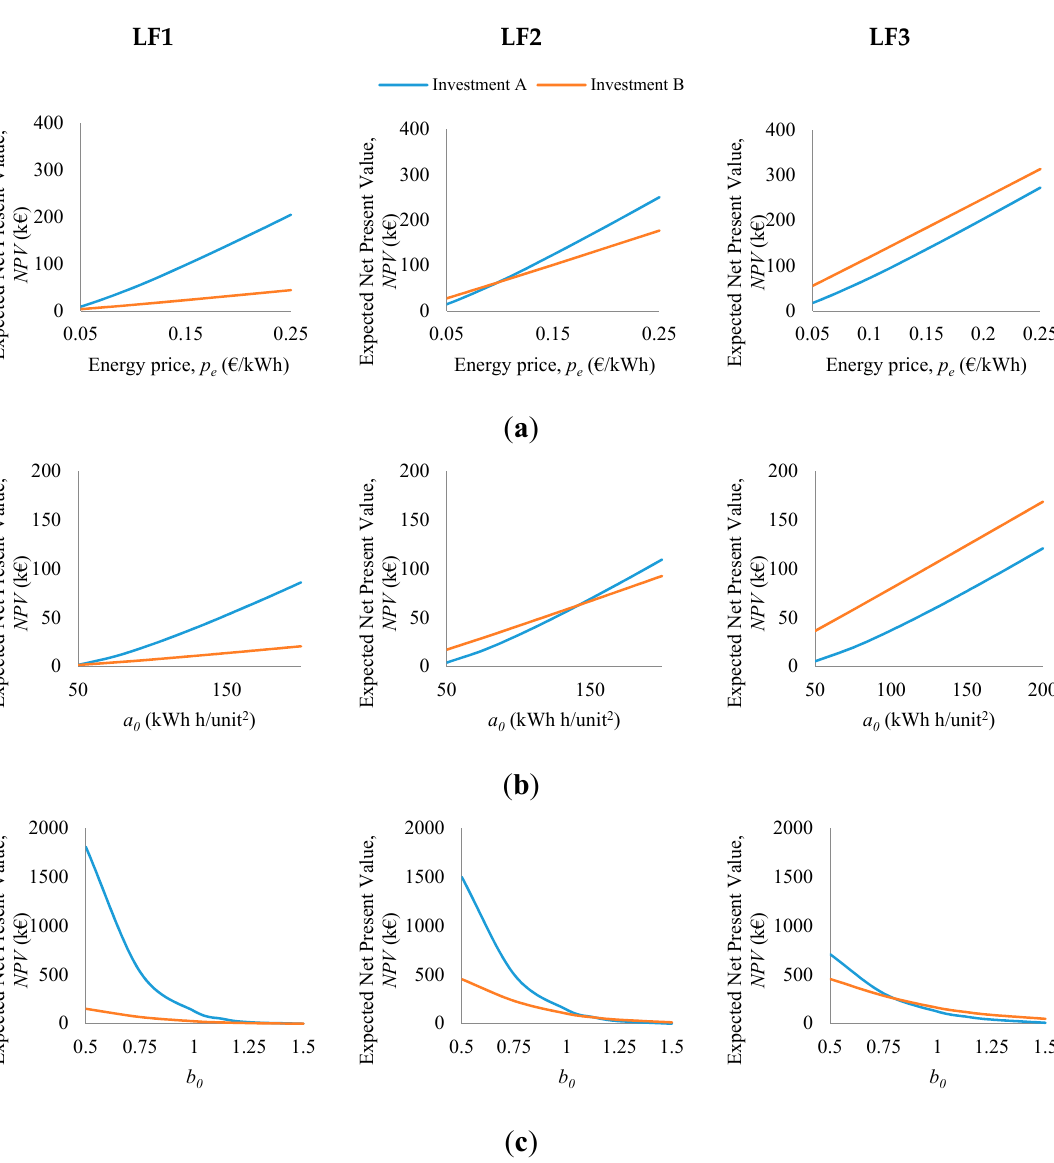
Figure 5. Variations in the net present value of the two investment options—“SEC Reduction” (Investment A) and “SEC levelling” (Investment B)—for each load factor by changing: ( a ) the energy price, p e , ( b ) the coe ffi cient a 0 , and ( c ) the coe ffi cient b 0 of the specific energy consumption without any investment.